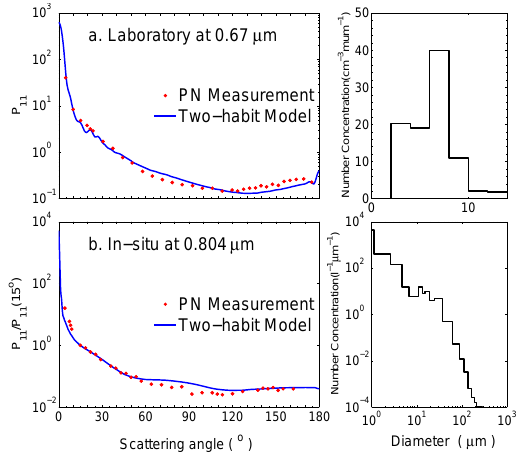
Figure 10. Comparison between the phase functions (left panels) from the two-habit model and the polar nephelometer (PN) mea- surements from the following: (a) laboratory at a wavelength of 0.67µm and (b) in situ at a wavelength of 0.804µm. The right pan- els are observed particle number concentration of the corresponding